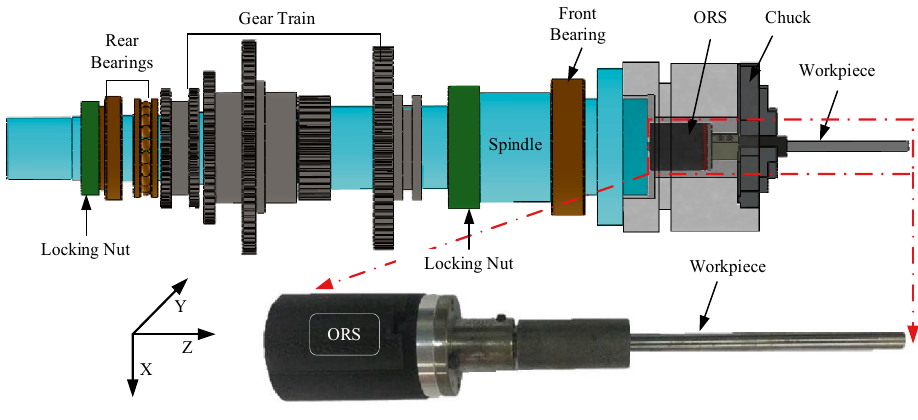
Figure 5. Finite element model of the spindle rotor system.